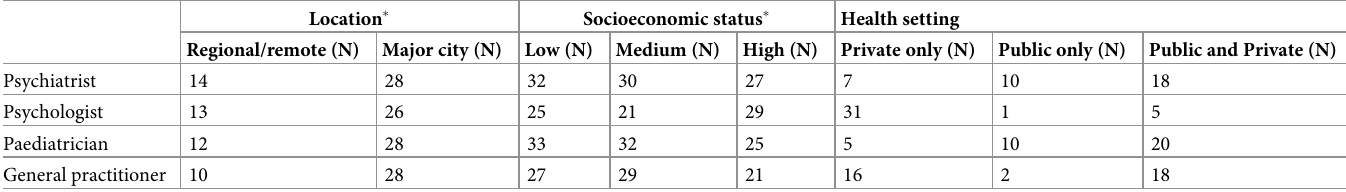
Table 1. Clinician characteristics by work